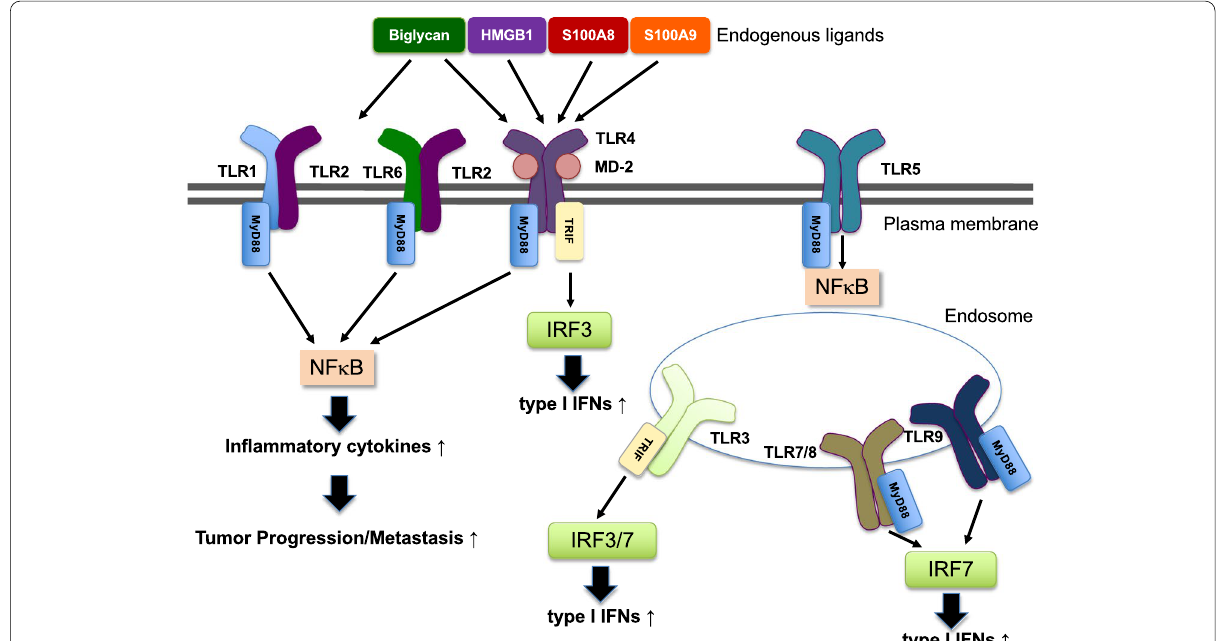
Fig. 1 TLRs involved in metastasis. TLR2 associates with TLR1 or TLR6. TLR4 recognizes LPS or endogenous ligands (i.e., biglycan, HMGB1, S100A8, S100A9). TLR3 is implicated in the recognition of viral dsRNA or exosomal RNA. TLR2, TLR3, or TLR4 are involved in cancer